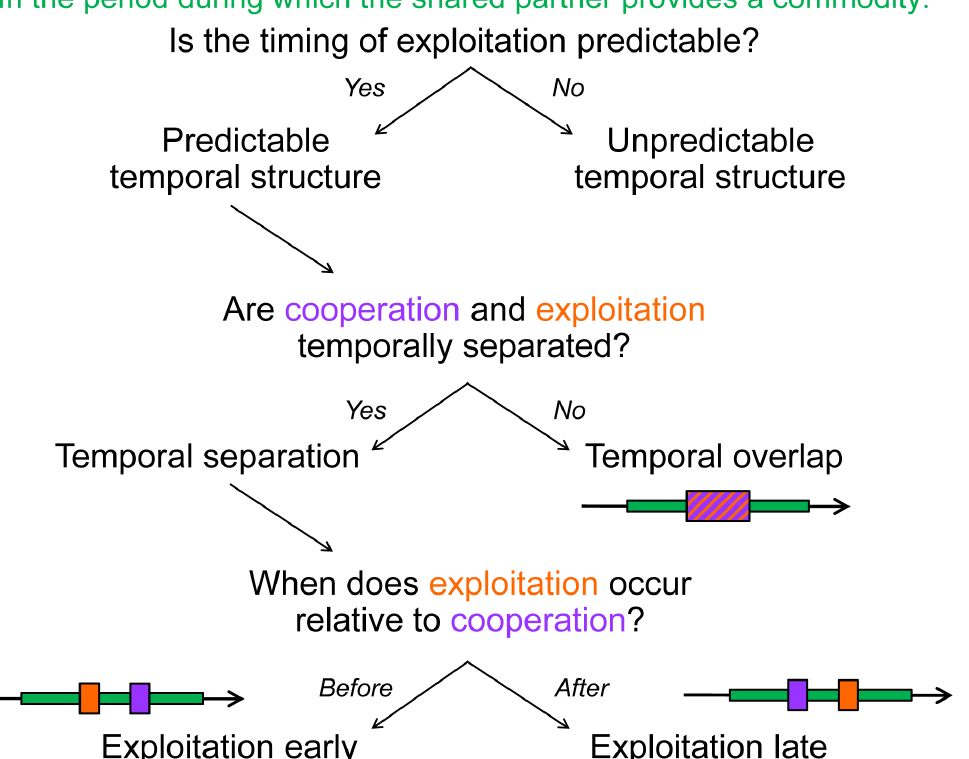
Fig 2. Categorizing temporal sequences of exploitation. The time period over which the shared partner provides a commodity is shown in green, and the times at which the mutualist and exploiter interact with the shared partner are shown in purple and orange, respectively. In this essay, we consider interactions with predictable temporal structure and ask how temporal overlap versus temporal separation (early versus late exploitation) affect the costs of and responses to being exploited.